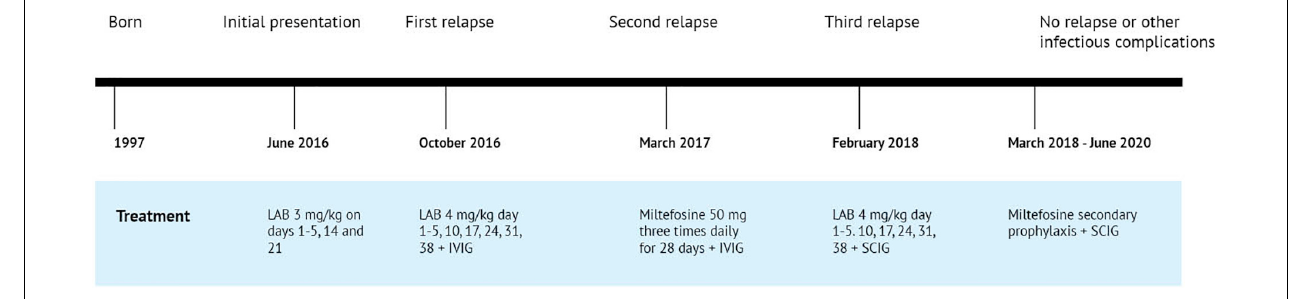
FIGURE 2 | Timeline of the clinical events and treatment strategies. LAB, liposomal amphotericin B; IVIG, intravenous immunoglobulin; SCIG, subcutaneous immunoglobulin.